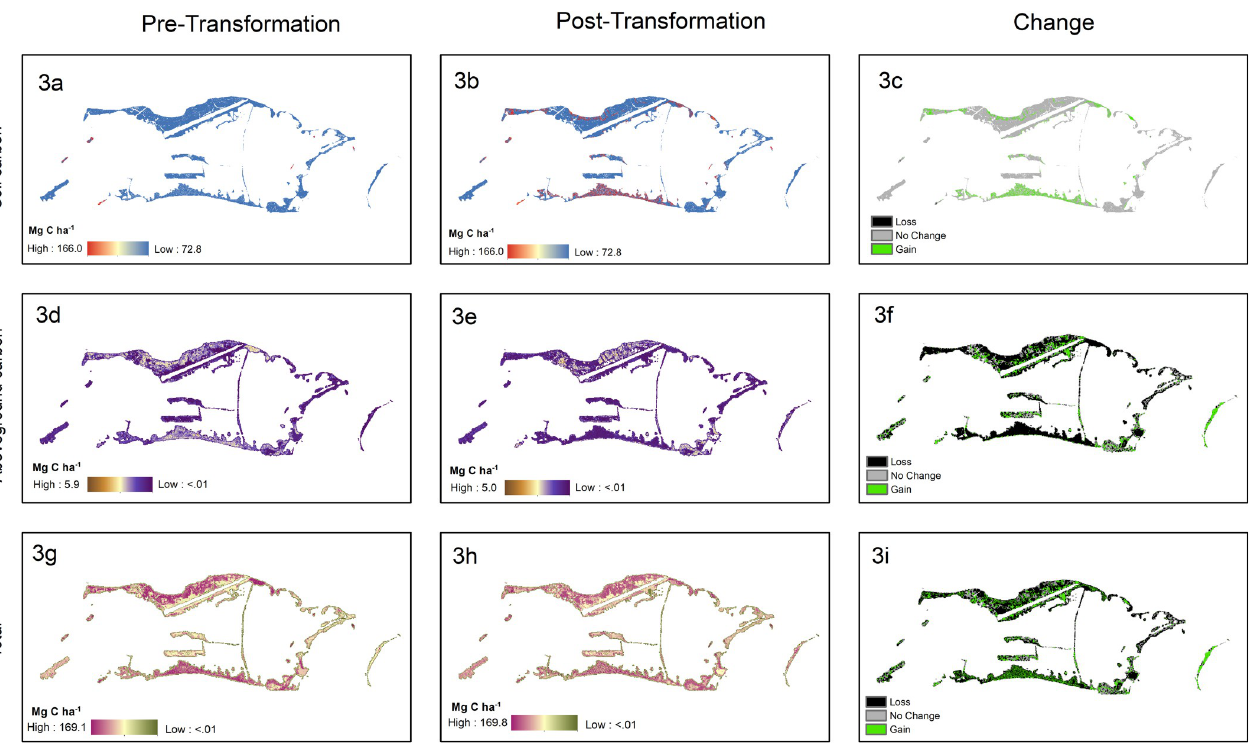
Fig 3. Maps of carbon distribution across the study area in the pre (column 1) and post (column 2) transformation scenarios. The third column shows the net gain and loss of carbon between the two scenarios. Fig 3A–3C show the results for soil carbon. Fig 3D–3F show the results for aboveground carbon. Fig 3G– 3I show the sum of the two carbon sources. Units are in Mg C ha -1 where the area includes only those areas partially or fully covered by a canopy (i.e. all areas other than those classified as runway, bare ground, grassland, and unknown land cover).